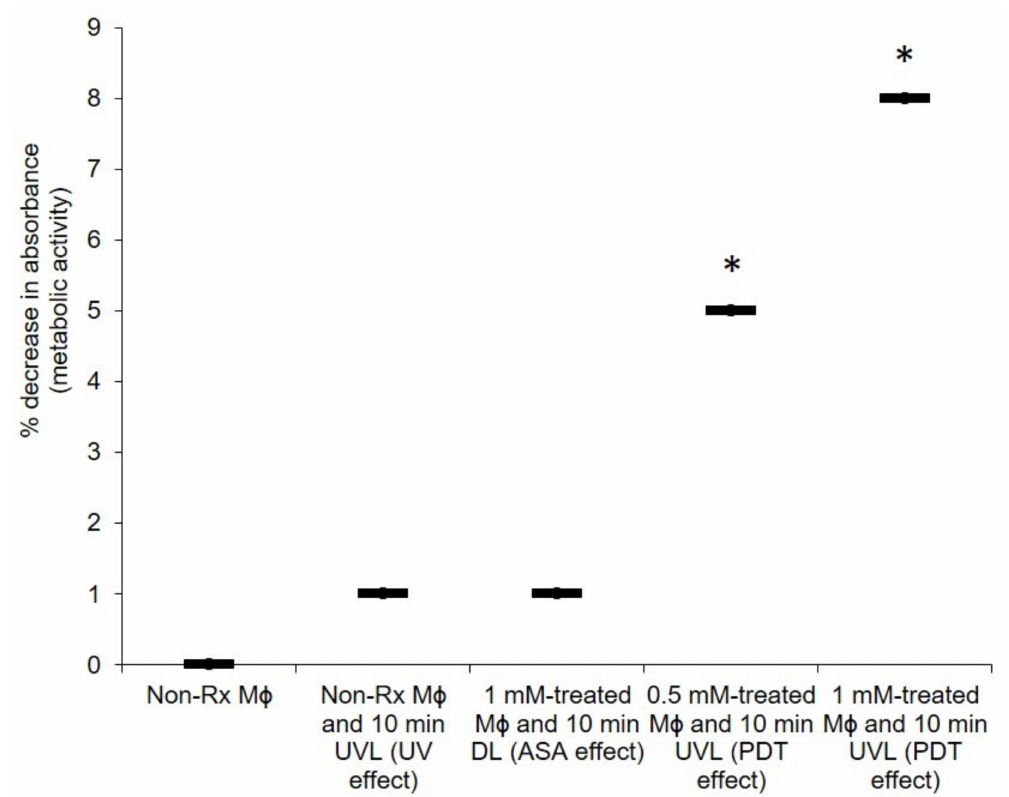
Figure 8. ASA is a suitable photosensitiser to apply against macrophages. The background signal of negative controls was used for normalisation. There was a normality of data distribution. Non-Rx, non-treated cells; UVL, ultraviolet light; DL, dark light; and M φ , macrophages. Data points were obtained from three biological replicates for each defined experimental condition. * Significantly different from non-Rx cells at p <